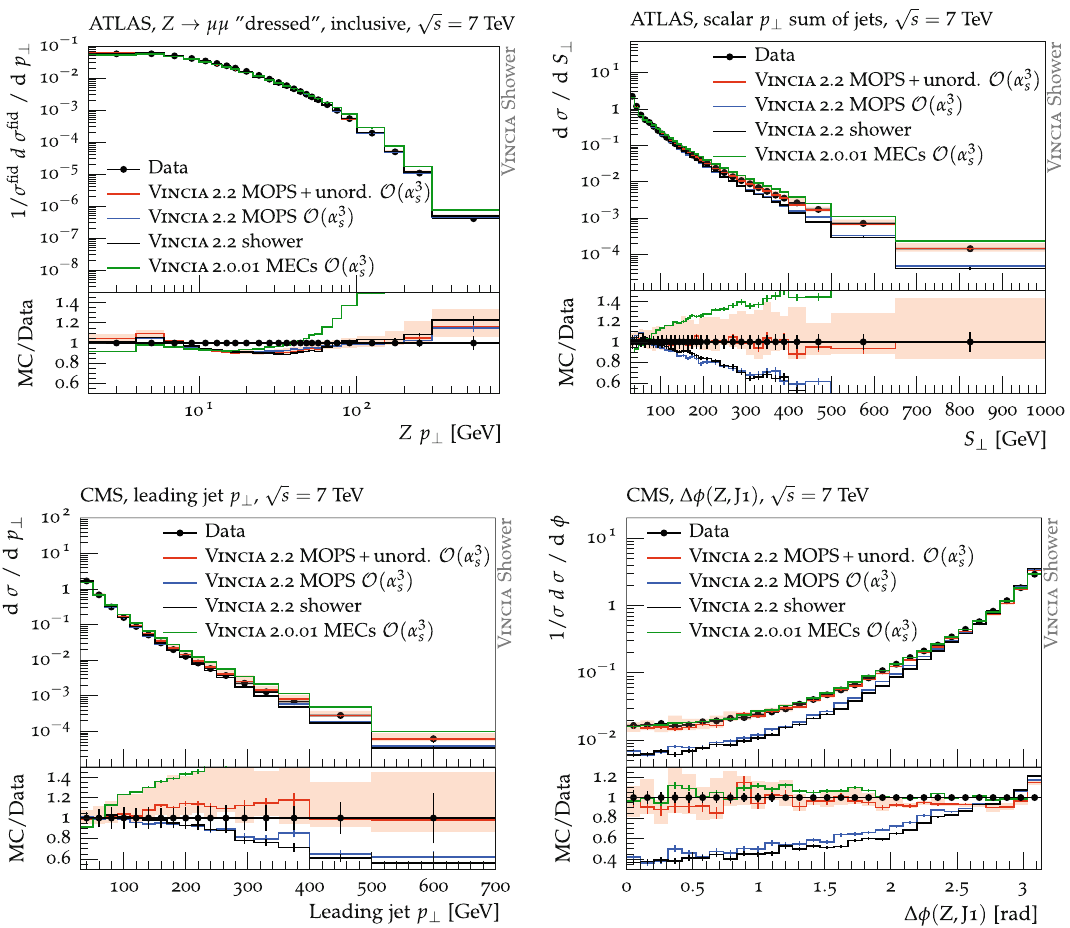
Fig. 4 Pythia 8.2.26+ Vincia 2.2 and Pythia 8.2.15+ Vincia 2.0.01 predictions compared to ATLAS data from [52,53] and CMS data